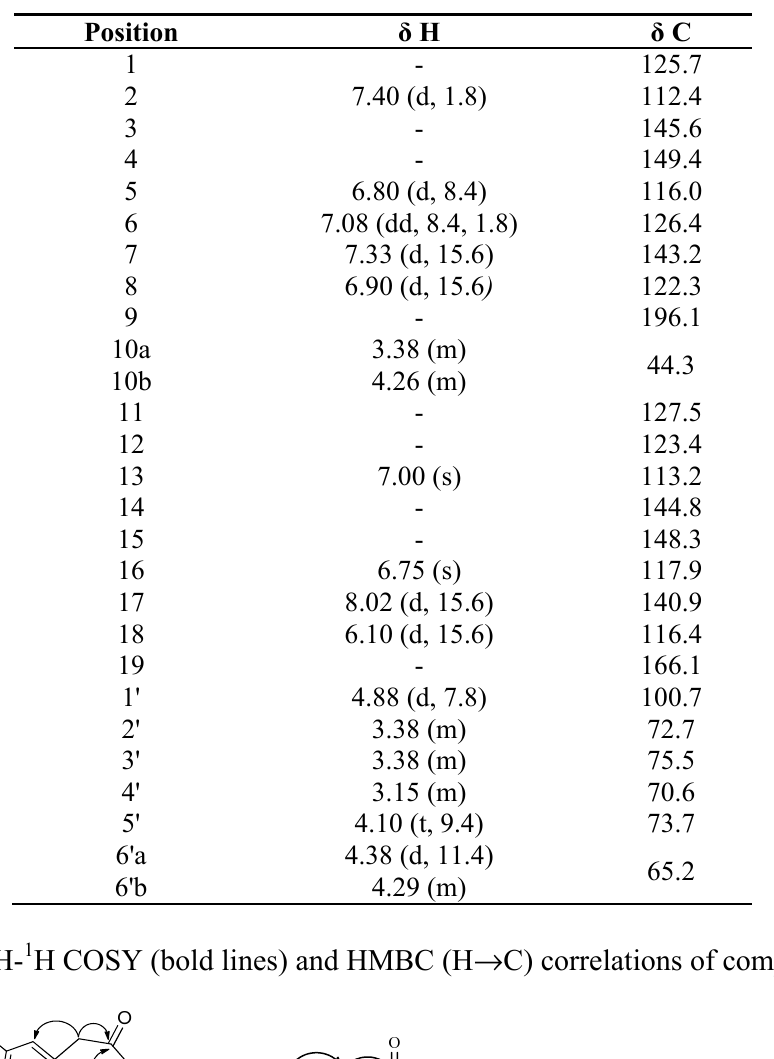
Table 1. 1 H-NMR (600 MHz) and 13 C-NMR (150 MHz) data for compound 1 (DMSO- d δ in ppm, J in Hz). H